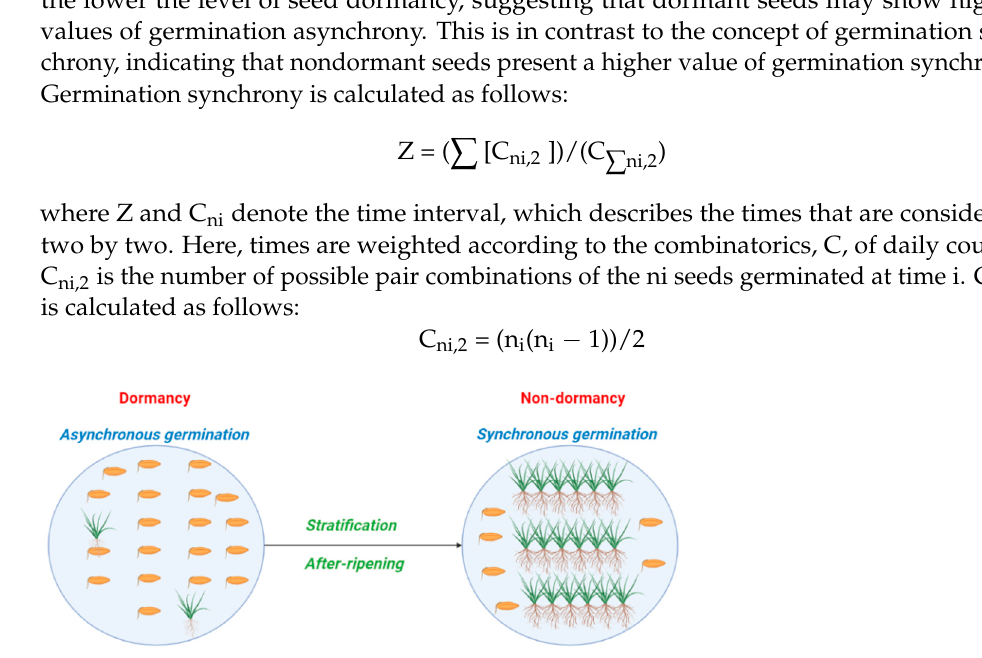
Figure 5. Germination behavior and synchrony patterns of seeds with non-deep physiological dormancy. Brassica napus and Sinapis arvensis have type 3 and 1 non-deep physiological dormancy, respectively.